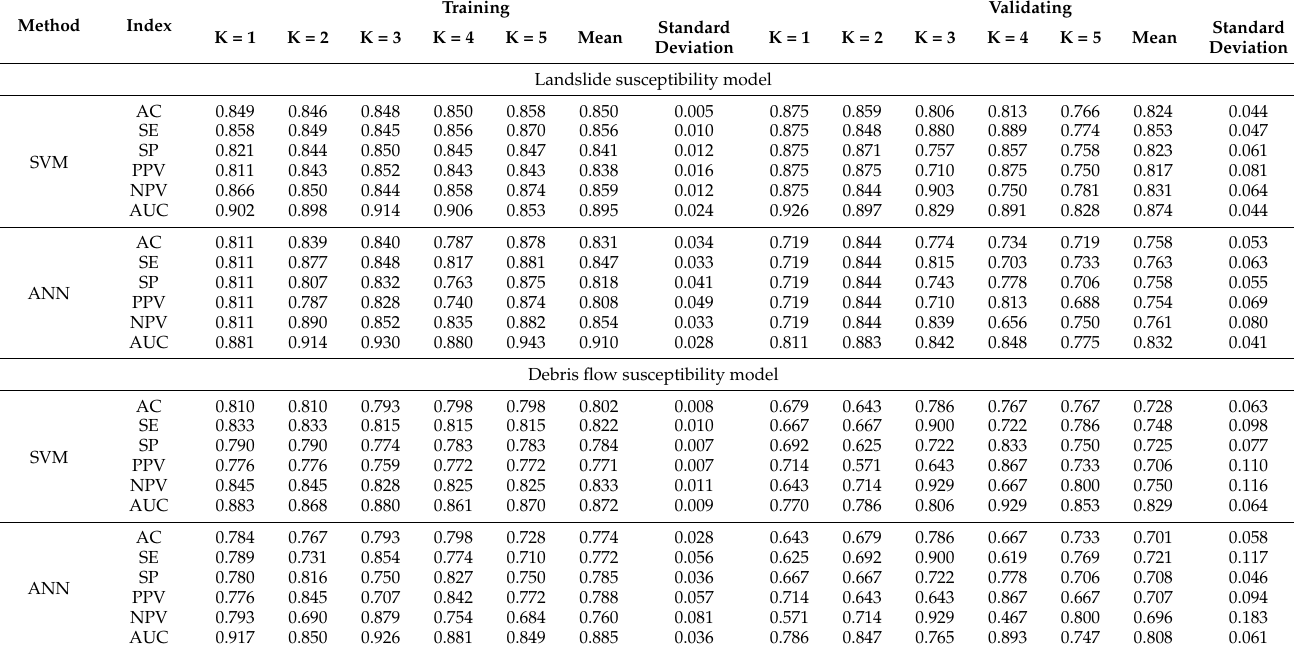
Table 4. The modeling results of the SVM model and ANN